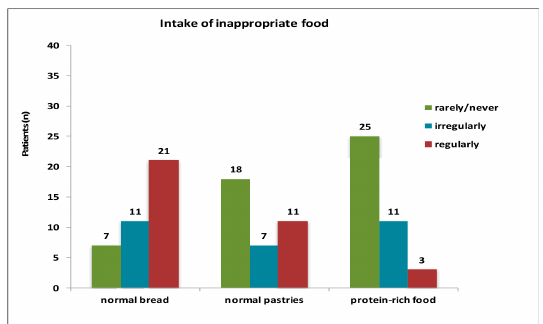
Figure A3. Intake of inappropriate food.